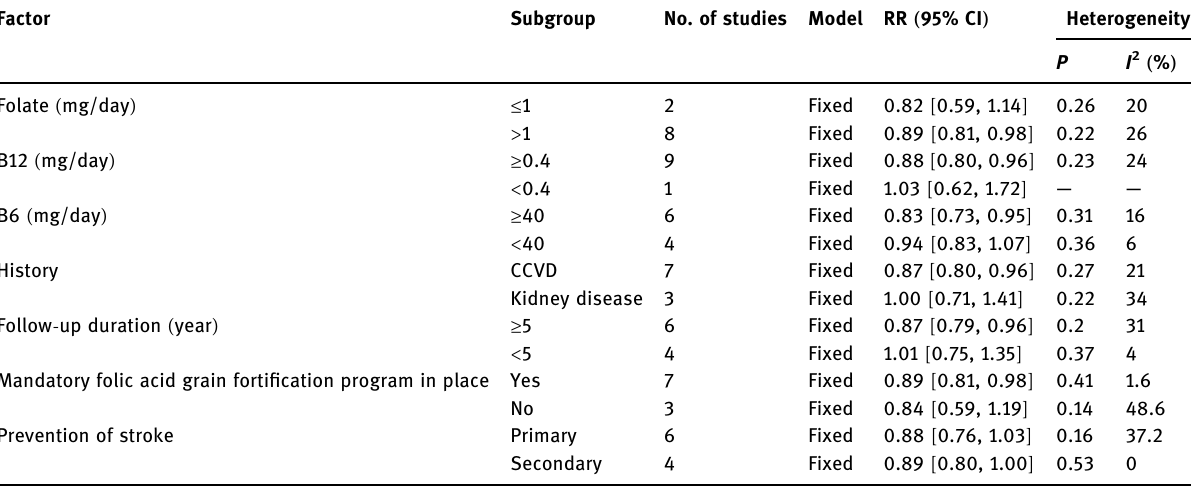
Table 2: Subgroup analysis of vitamin B supplementations and the risk of stroke Factor Subgroup No. of studies Model RR ( 95% CI